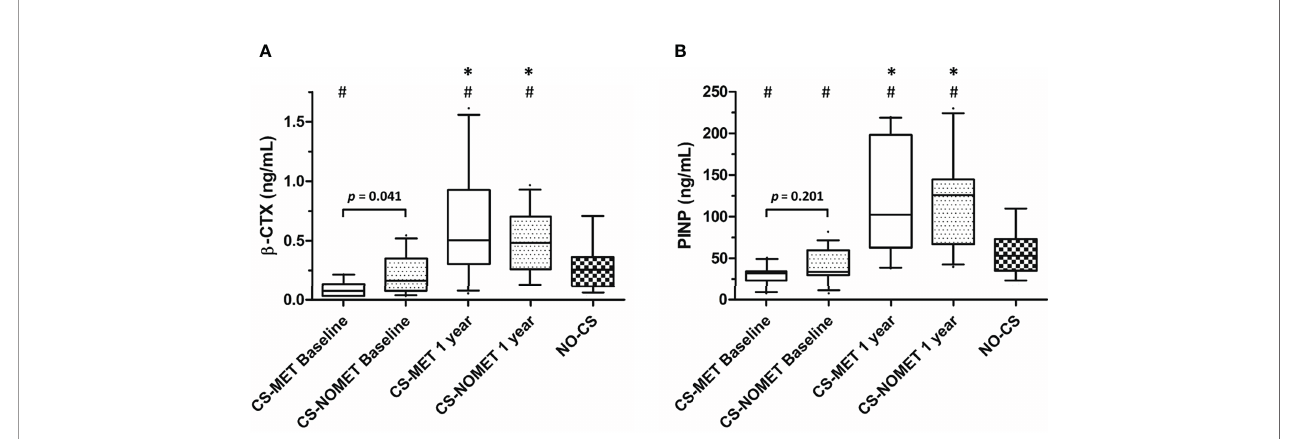
FIGURE 3 | Bone turnover markers during glucocorticoid excess and one year after surgically induced remission in patients with endogenous Cushing ’ s syndrome (CS). Pre-existing metformin treatment (CS-MET): n = 10; no pre-existing metformin treatment (CS-NOMET): n = 16; patients with excluded CS (NO-CS): n = 95. (A) b -CTX = b -Crosslaps; (B) PINP = procollagen I-N-propeptide. Box and whiskers (10-90 percentile). Comparison between groups was performed by a Mann-Whitney-U-Test, between time points by a Wilcoxon signed rank test; p ≤ 0.05 was considered statistically signi fi cant. * p ≤ 0.05 versus baseline; # p ≤ 0.05 versus ‘ NO-CS ’